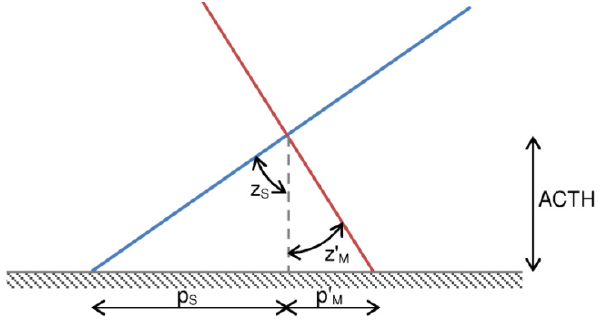
Figure 2. The scheme of observations of a cloud from two directions (subscripts at the parallax p and zenith angle z correspond to S for the blue line directed to SEVIRI and M for the red line directed to MVIRI). The cloud is positioned at the intersection of the coloured lines. The scheme presents the plane defined by the normal to the WGS84 ellipsoid and the direction of the longest parallax (here the blue line). The other line is projected (the apostrophe on the symbol denotes that the parameter has been projected on the same plane by multiplying the parallax by the cosine of the angle between the red and blue lines).